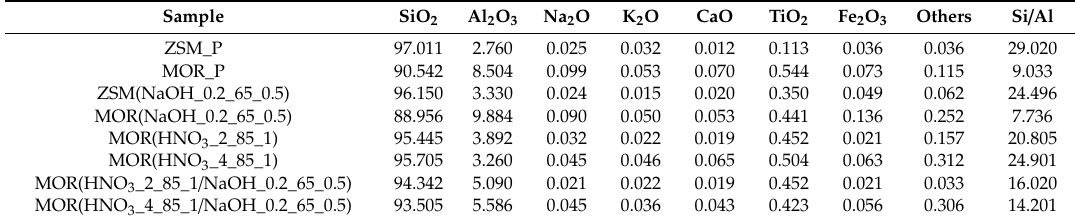
Table 2. Chemical composition of the studied